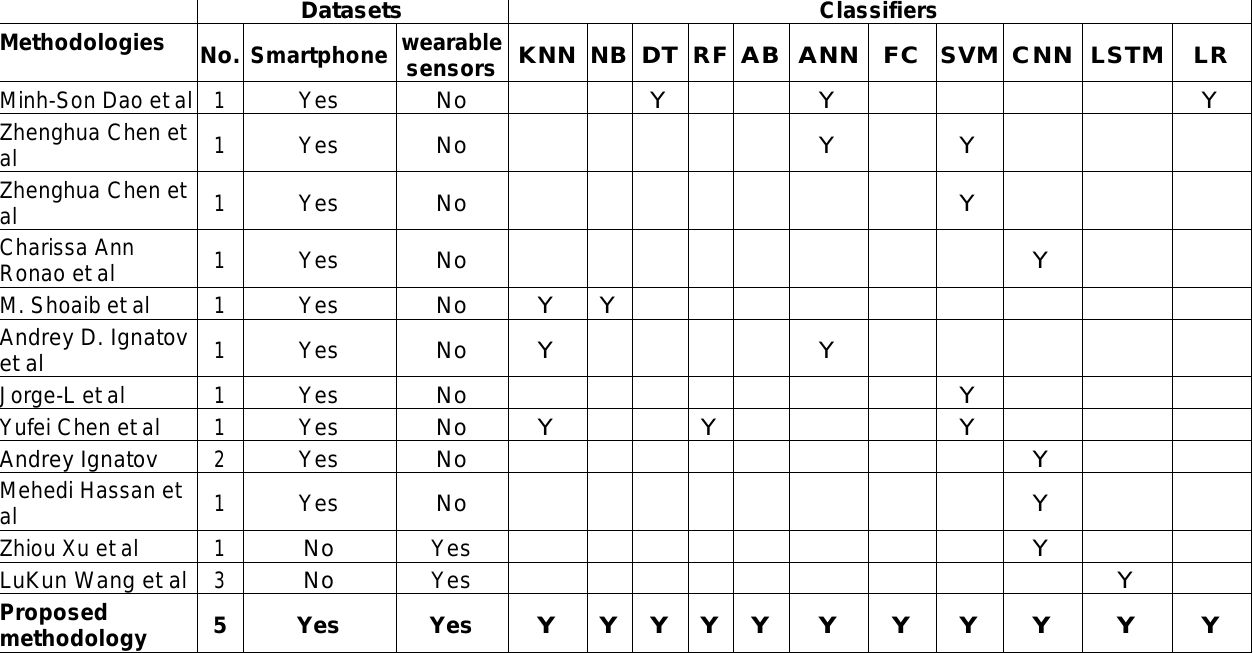
Table 1. Summary of selected methods for sensors or smartphone based Human Activity